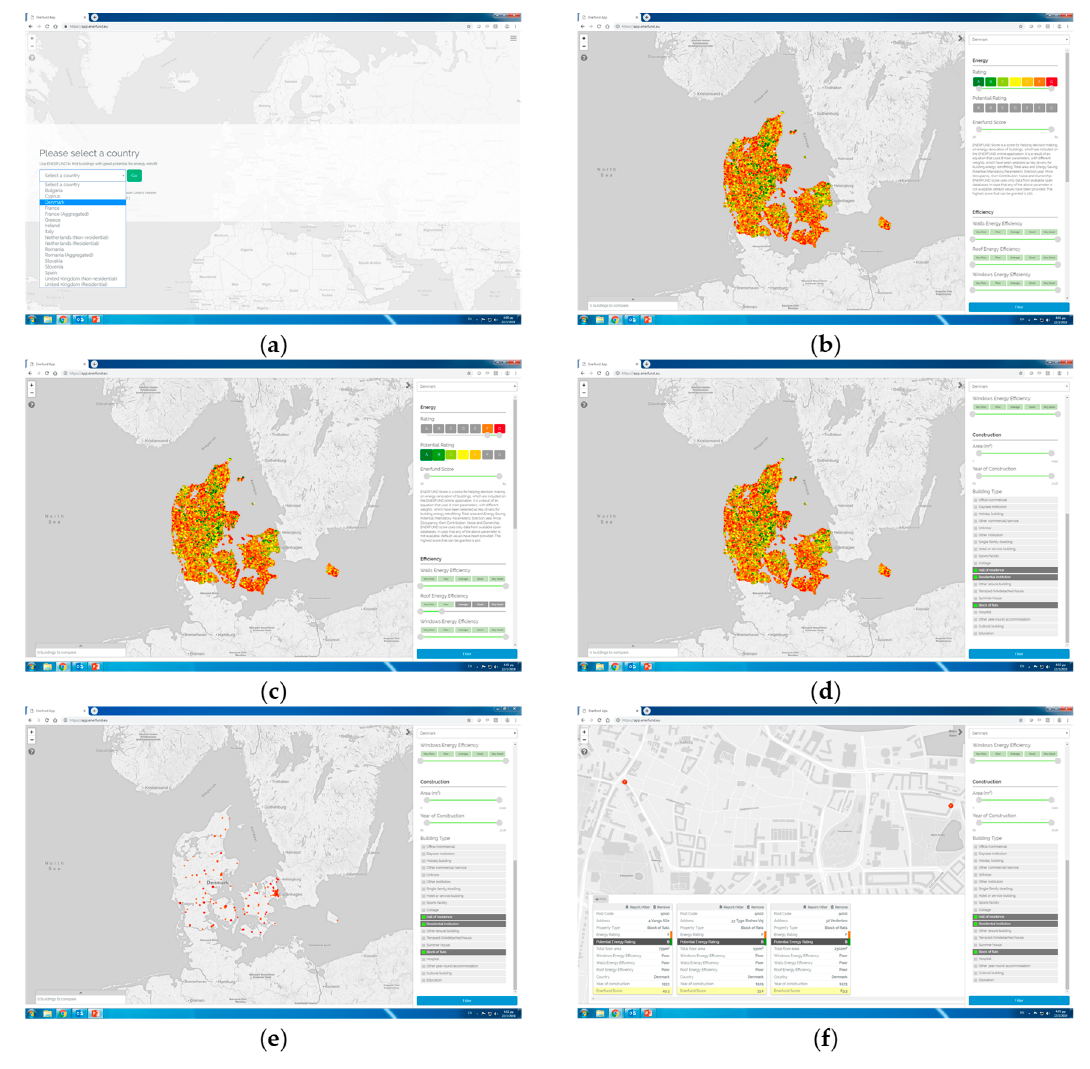
Figure 1. An example of how to use the ENERFUND tool.